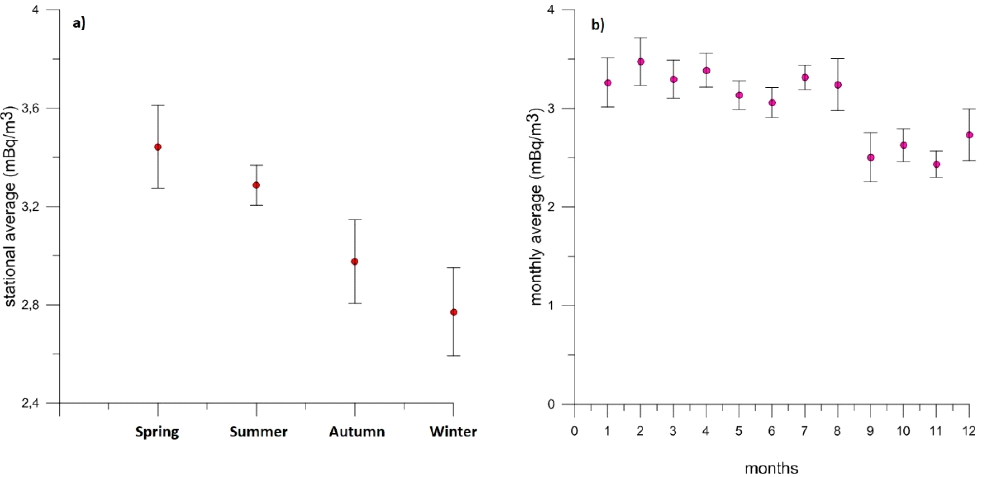
2009 to Figure 7. 7 Be activity concentrations, and 1 σ error bars, on ( a ) seasonal and ( b ) monthly basis from 2009 to 2018.